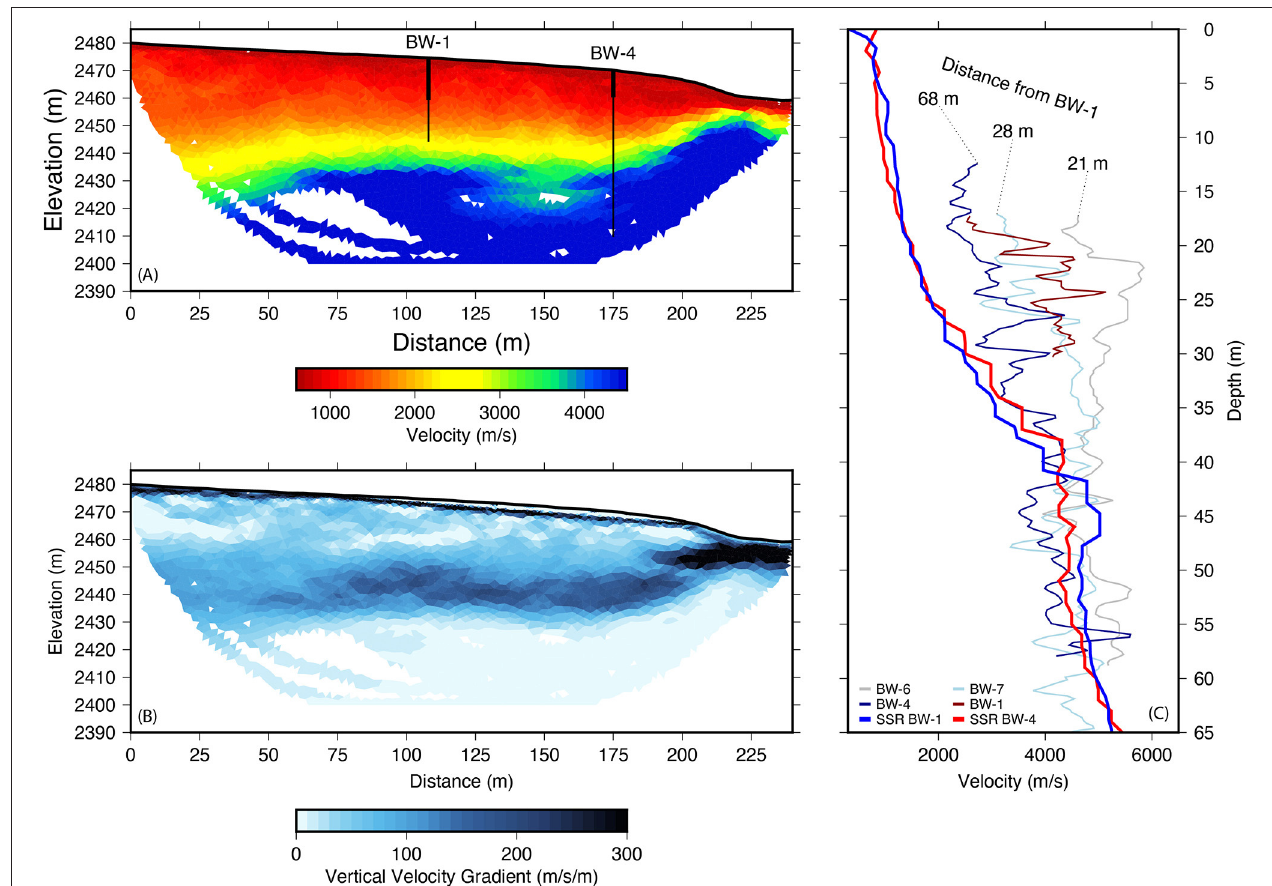
FIGURE 6 | Travel-time tomography results for L29. (A) Final P-wave velocity model estimated by travel-time tomography. Model fits and uncertainty are provided in the supplementary material ( Supplementary Figure S2 ). The models are masked by ray paths. Borehole locations are show as vertical line where the thickest part of the line represents the casing. The bottom of casing is interpreted to indicate the top of fractured bedrock. The profile intersected BW-1 at 108m and BW-4 at 175m. BW-6 and BW-7 both occur at 80m along the profile but do not intersect. BW-6 is ∼ 10m south of the profile and BW-7 is ∼ 10m north of the profile. (B) Vertical gradient of velocity calculated at each pixel in the model. Dark colors indicate a sharp increase in velocity vertically and highlight the location of the strong elastic boundary in the model. (C) Comparing the refraction and sonic velocities. In this plot, everything is converted into the depth domain using the topography from the LiDAR ( Figure 1 ). The thin colored lines are sonic velocity profiles from the borehole logs. Logs start at different depths because of different casing depths and variations in the water table. Distances from BW-1 are marked on each profile. The thicker blue and red lines are extracted vertical velocity profiles from panel a from BW-1 and BW-4 locations shown at 108 and